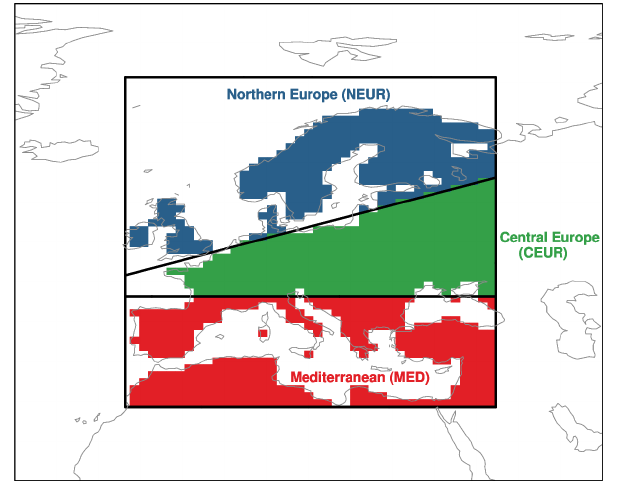
Figure 1. The SREX regions over which area-averaged projections and observations are analysed in this study, following Field et al.